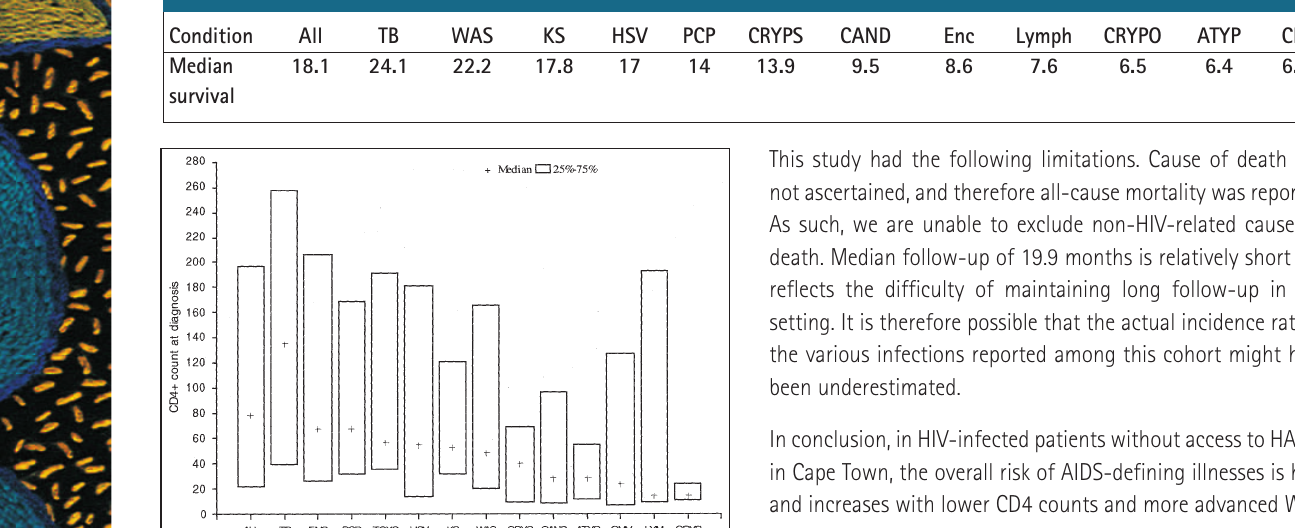
TABLE III. KAPLAN-MEIER PROBABILITIES OF SURVIVAL FOLLOWING DIAGNOSIS.